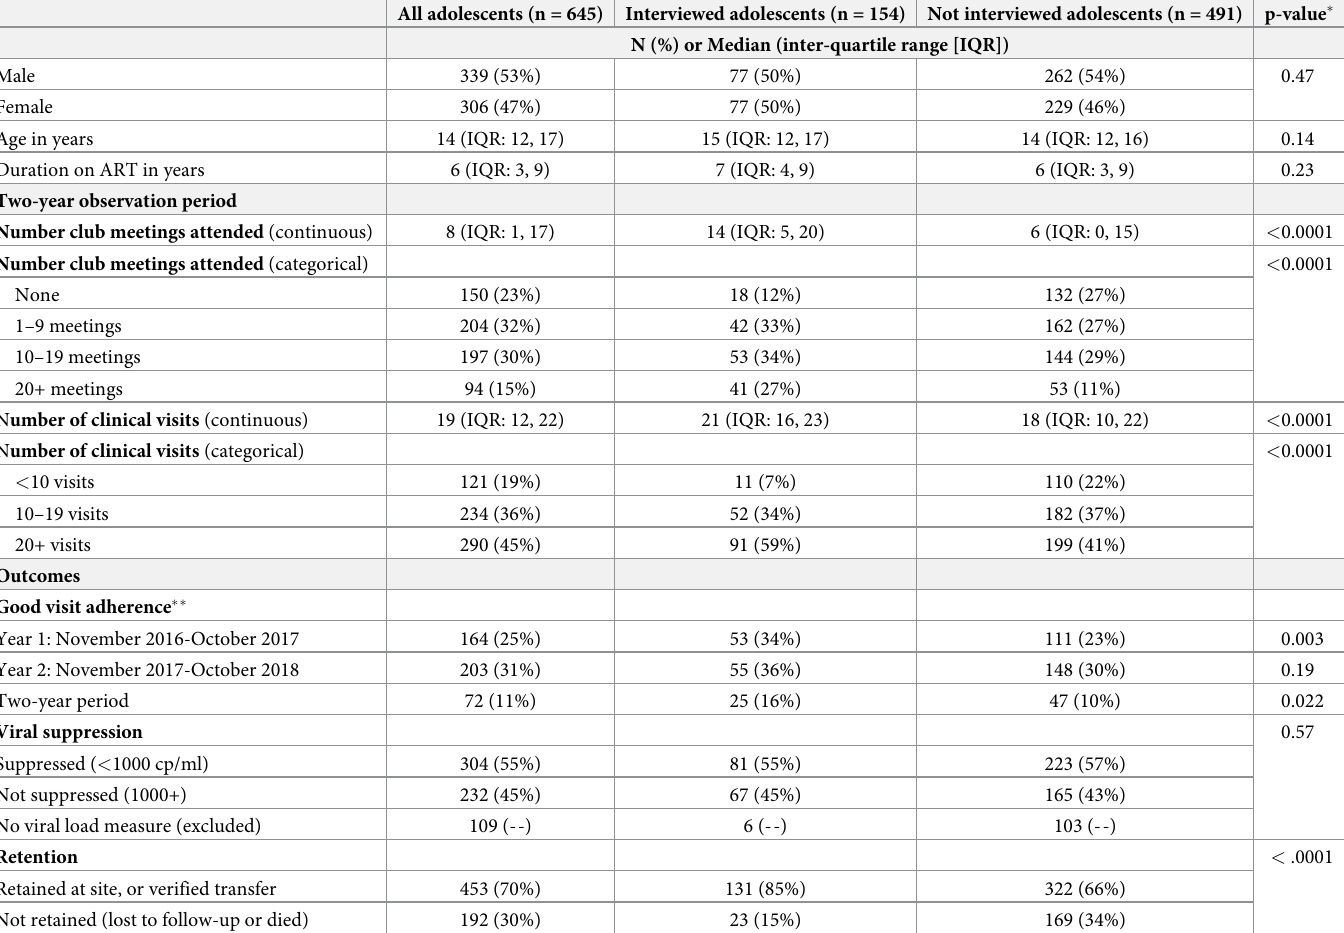
Table 1. Characteristics and study outcomes for all adolescents attending study sites (n = 645), stratified by whether they participated in the interview (n = 154) or not (n = 491). All adolescents (n = 645) Interviewed adolescents (n = 154) Not interviewed adolescents (n = 491) p-value